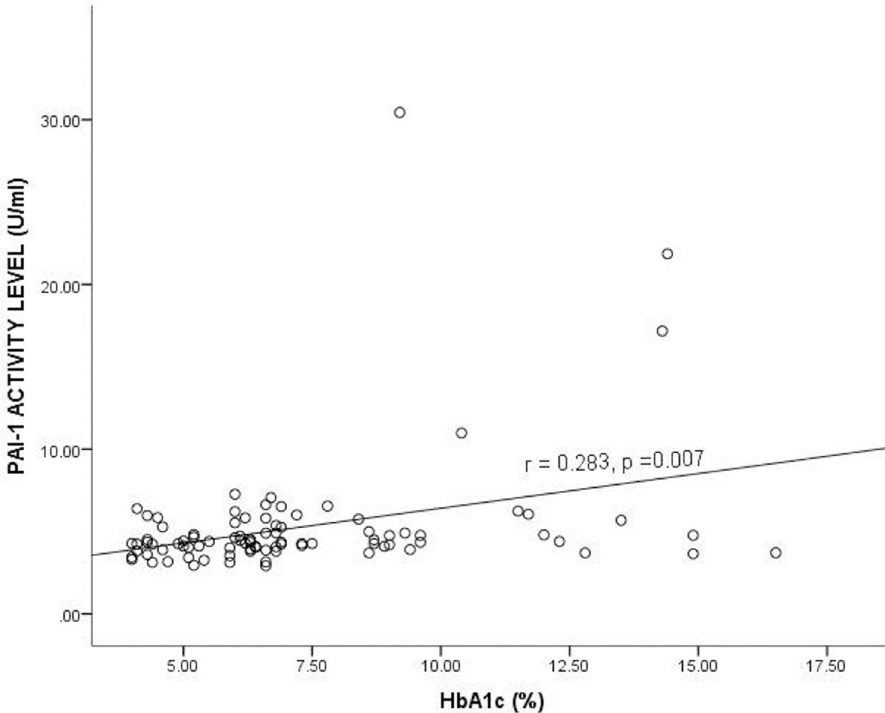
Fig 2. Correlation between Plasminogen Activator Inhibitor-1 activity level and glycated hemoglobin among the study participants. HbA1c = Glycated hemoglobin, PAI-1 = Plasminogen activator inhibitor 1, r = Correlation coefficient. Spearman correlation was used to determine the correlation between the plasma PAI-1 activity level and HbA1c. p < 0.05 was considered statistically significant.